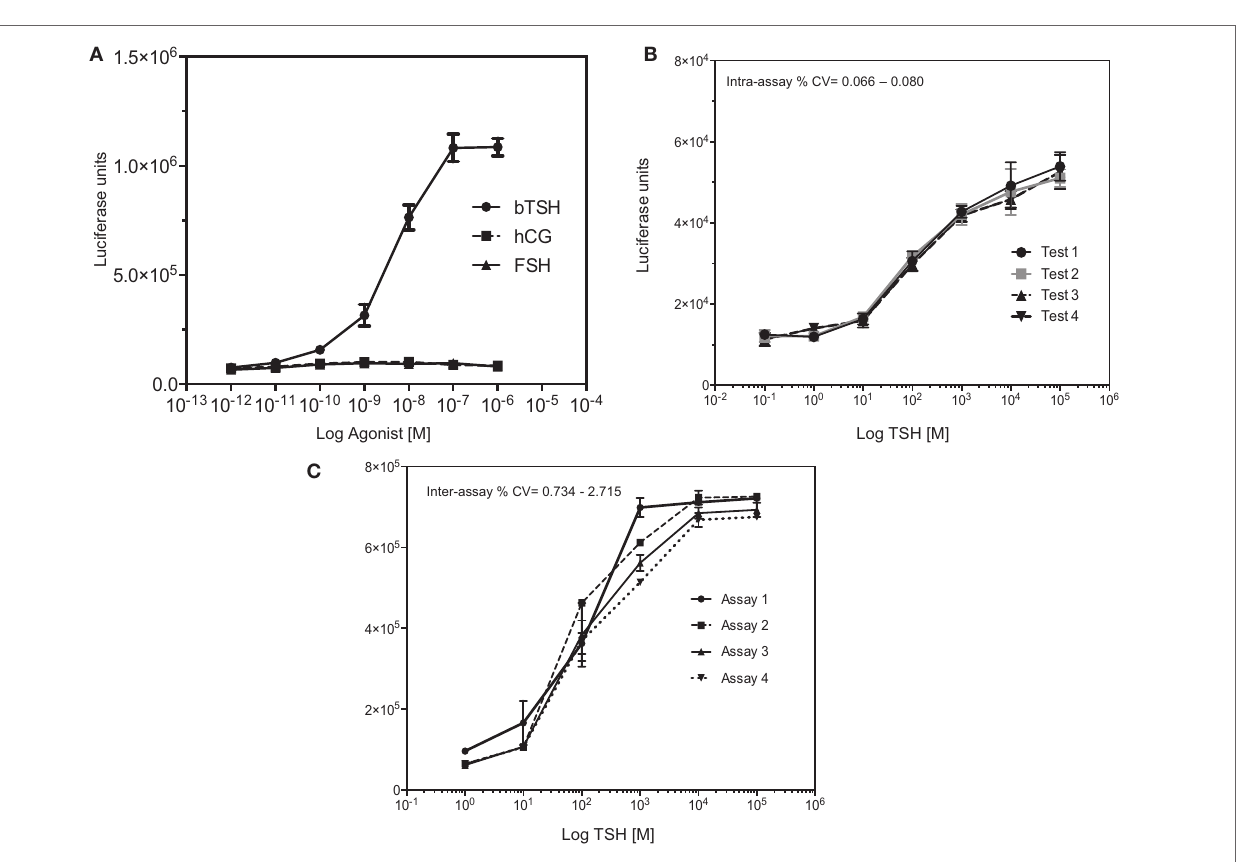
FIGURe 3 | specificity of the tshR-Glo assay. (A) The specificity of the assay was examined by dose–responses curves against TSH, hCG, and FSH hormones. As indicated, the assay showed no responses to hCG or FSH at the concentrations tested here but a dose-dependent increase in luciferase signal. (B,C) In order to test the heteroscedasticity of the assay, we measured response of increasing doses of TSH in an inter- and intra-assay format as indicated by graphs. Intra-assay exhibited very minimal variability compared to the inter assay though both had CVs < 5%.